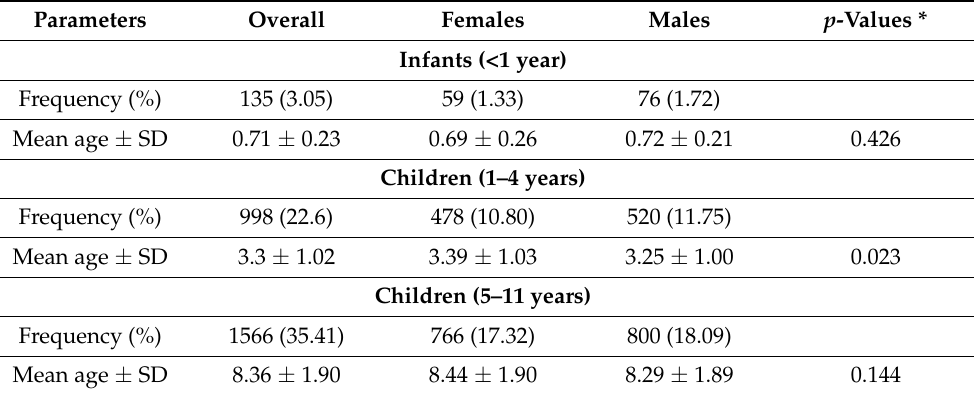
Table 1. Demographic parameters of SCD patients. Mean values were obtained after finding the mean ages within the individual level for each